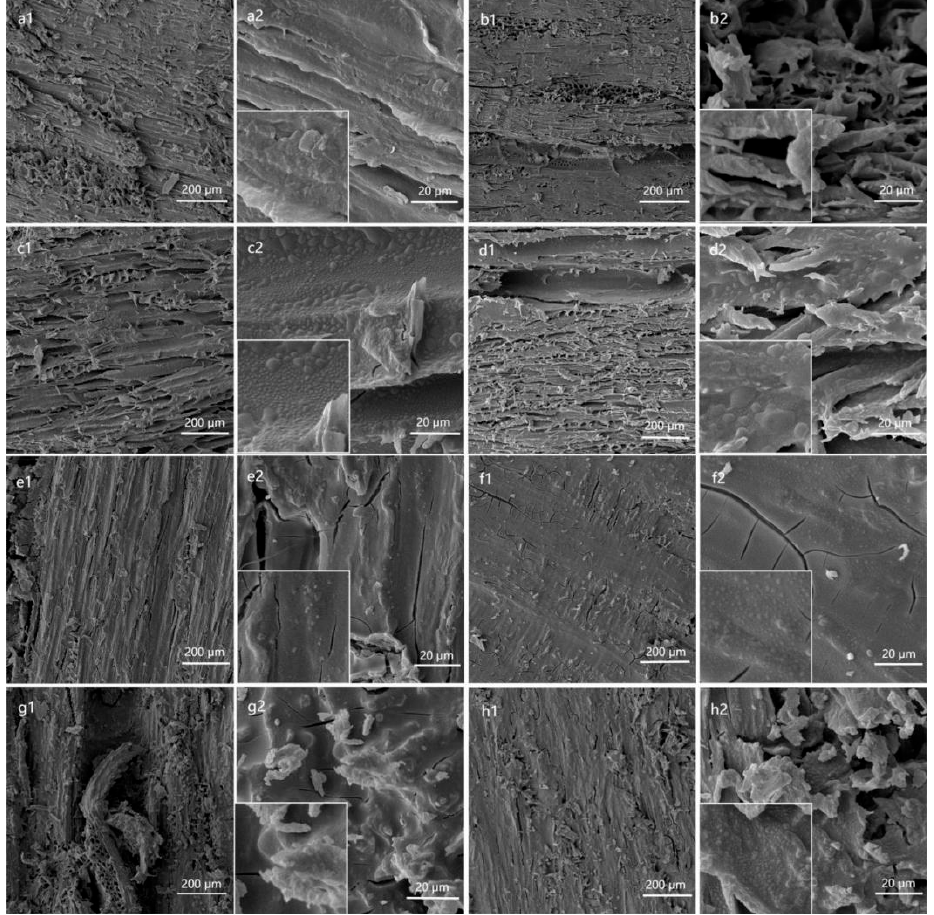
Figure 4. SEM image of superhydrophobic coating surface of eight kinds of wood. ( a Poplar wood, b elm wood, c Chinese toon wood, d paulownia wood, e beech wood, f ashtree, g black walnut wood, h rosewood) low magni fi cation, high magni fi cation and locally enlarged image.